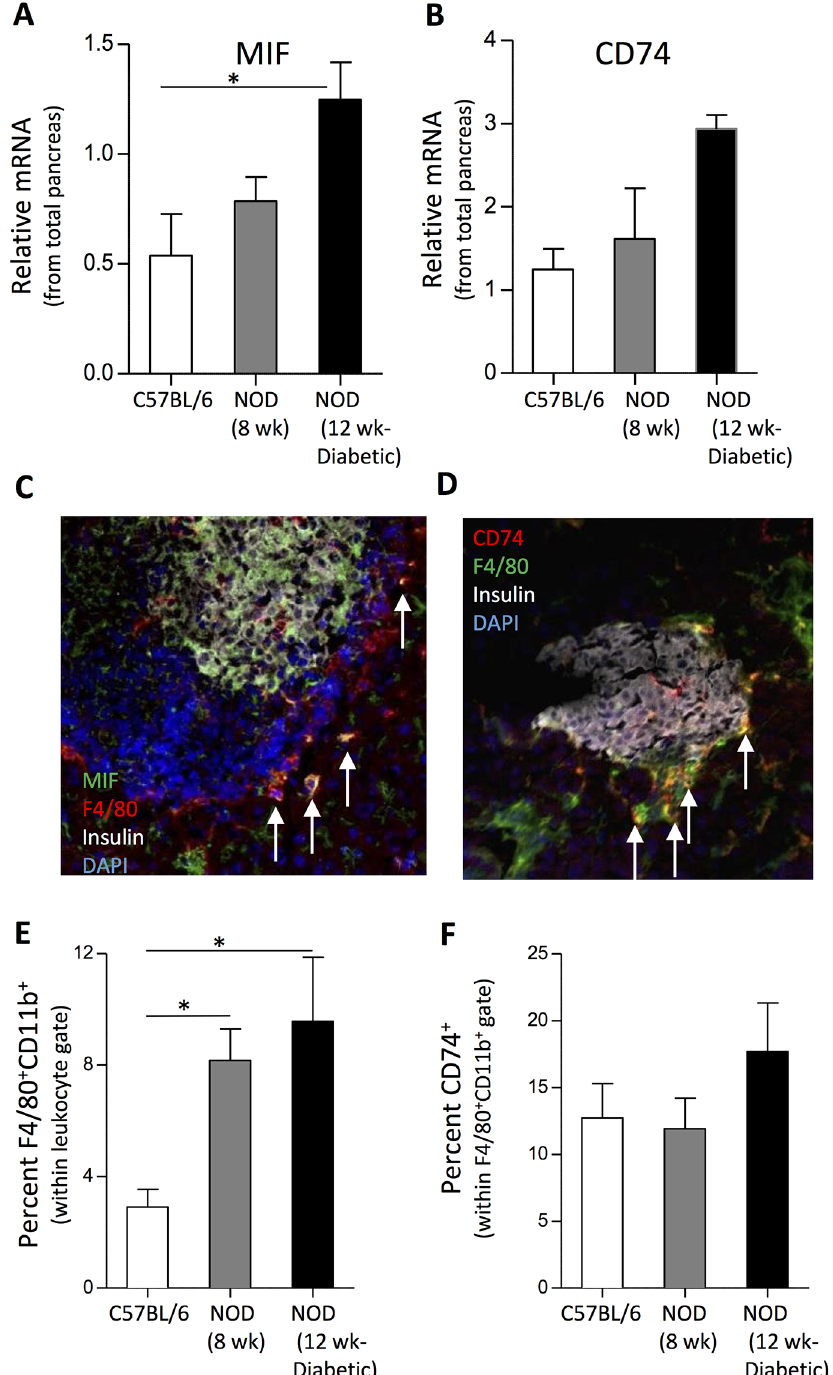
Fig 2. Quantification and visualization of MIF and CD74-expressing cells in the pancreasof NOD mice. Quantificationof the relative MIF and CD74 mRNA levels in the total pancreasof control and NOD mice by means of real-time reverse transcription PCR (RT-PCR) (Mean ± SEM; n = 4–5) (A &B) ( * : p- values (cid:20) 0.05). (C) Pancreaticsections of NOD mice were stainedfor insulin(white), MIF (green), F4/80 (red) and DNA by DAPI (blue) and analyzedwith confocalmicroscopy at × 40 originalmagnification. Cells featuring a co-localization of MIF and the macrophagemarker F4/80 are indicatedby the white arrows. (D) Confocal microscope image of pancreatic sections of NOD mice were stained for insulin(white), CD74 (green), F4/80 (red) and DNA by DAPI (blue) ( × 40originalmagnification). The images depictedshows one representative